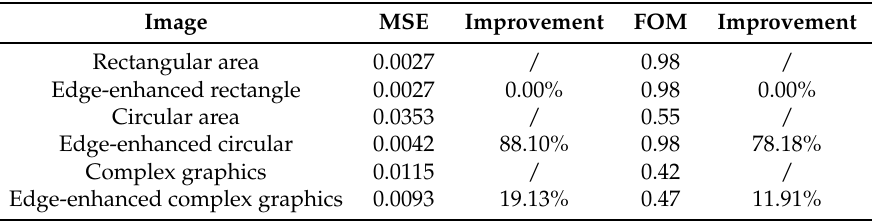
Table 2. Supervised evaluation of edge detection. Mean square error (MSE), Pratt’s figure of merit